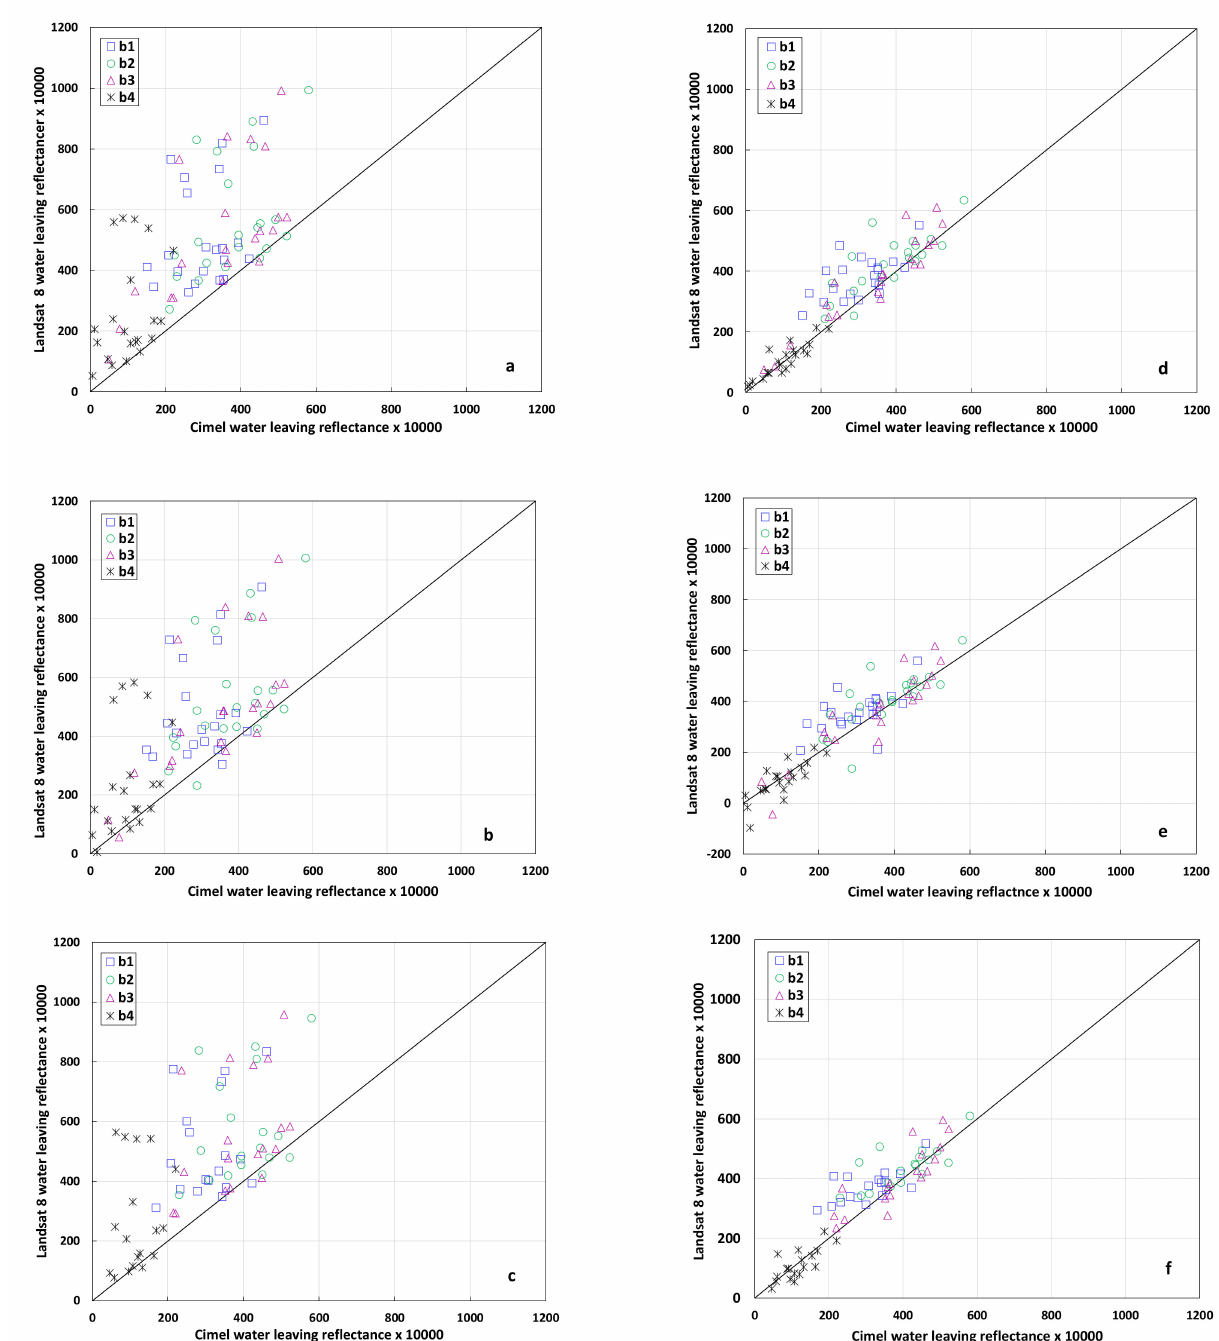
Figure 3. Comparison between satellite-derived water-leaving reflectance ( ρ w ) from different processing versions (Table 3) and in situ observations: ( a ) version 1; ( b ) version 2; ( c ) version 3; ( d ) version 4, ( e ) version 5; and ( f ) version